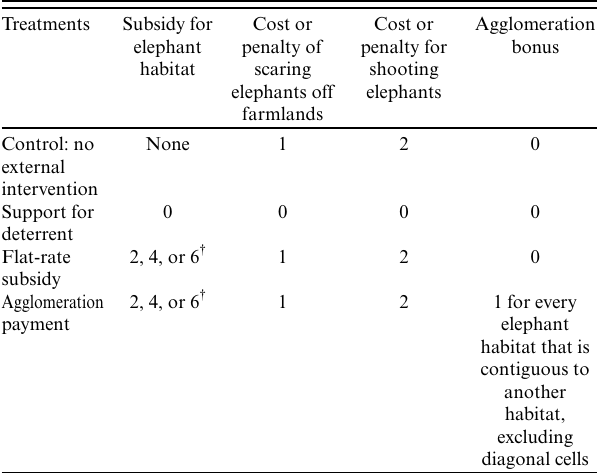
Table 1. Treatment conditions for the game